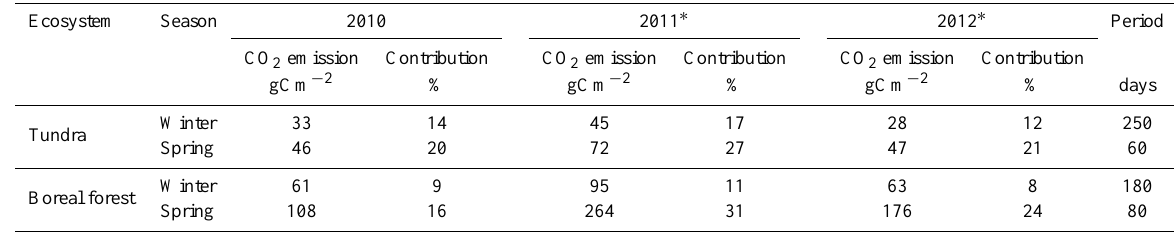
Figure 6. Spring CO 2 efflux responses to (a) snow depth and (b) soil temperature at 5cm below the surface, with and without snow crust at tundra sites during the spring. Dotted and solid curves denote the 3-year exponential relationship between spring CO 2 efflux and (a) snow depth and (b) soil temperature, before and after cluster removal. Table 4. Contributions (%) from seasonal CO 2 emissions to the annual carbon budget in tundra and boreal forest ecosystems, under the average seasonal period during 2010 and 2011 ∗